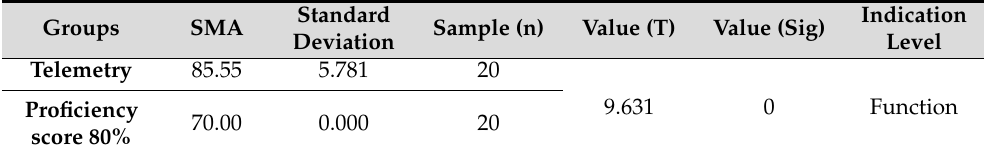
Table 7. Significance of differences between average scores of control groups and specific degree of proficiency 80% in skill test of practical experiment skills.